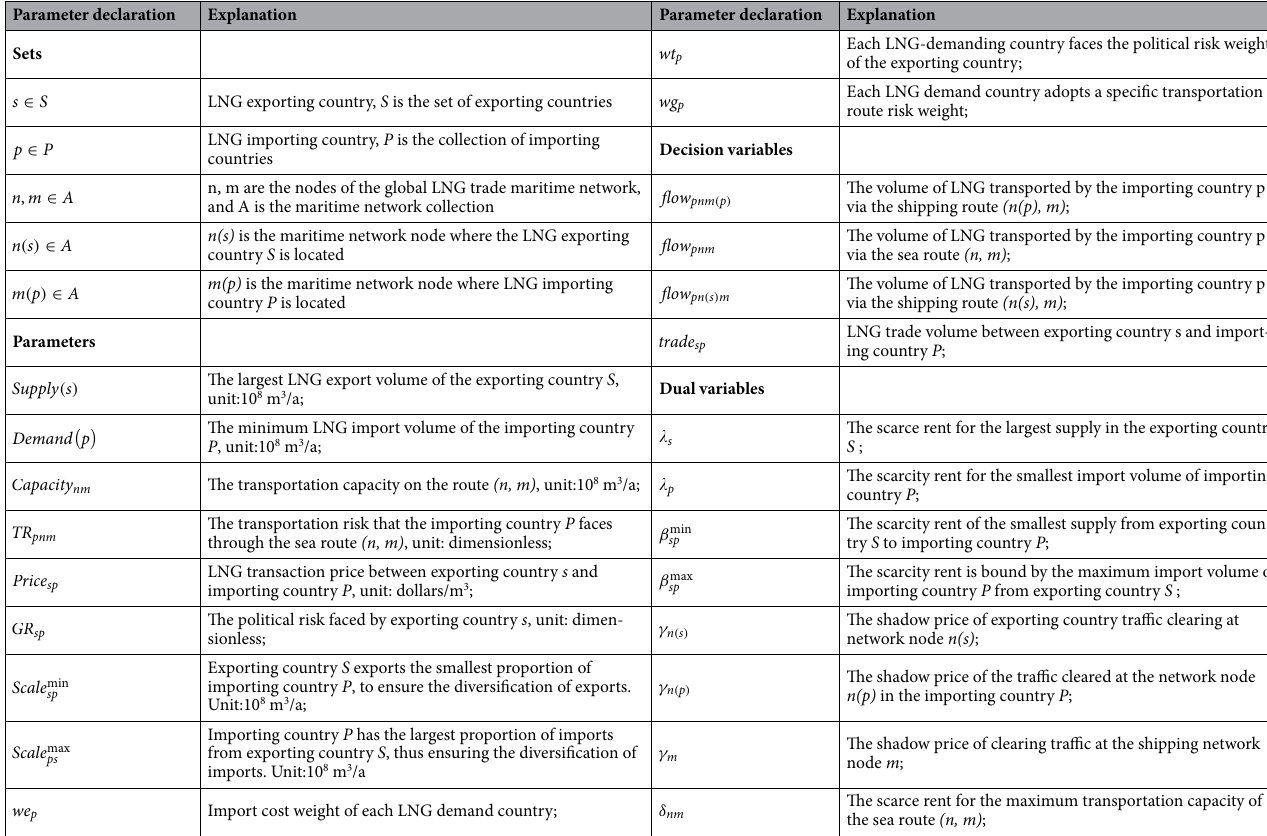
Table 2. List of model parameters and their